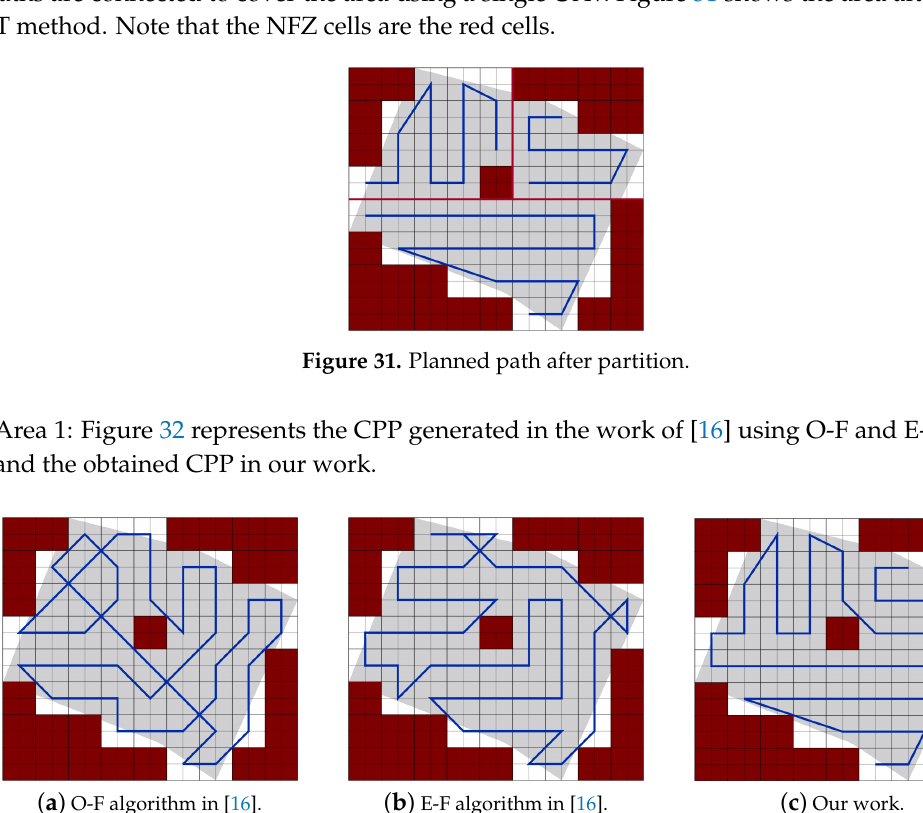
Table 12. CPP path provided in Ref. [16] vs. our CPP.